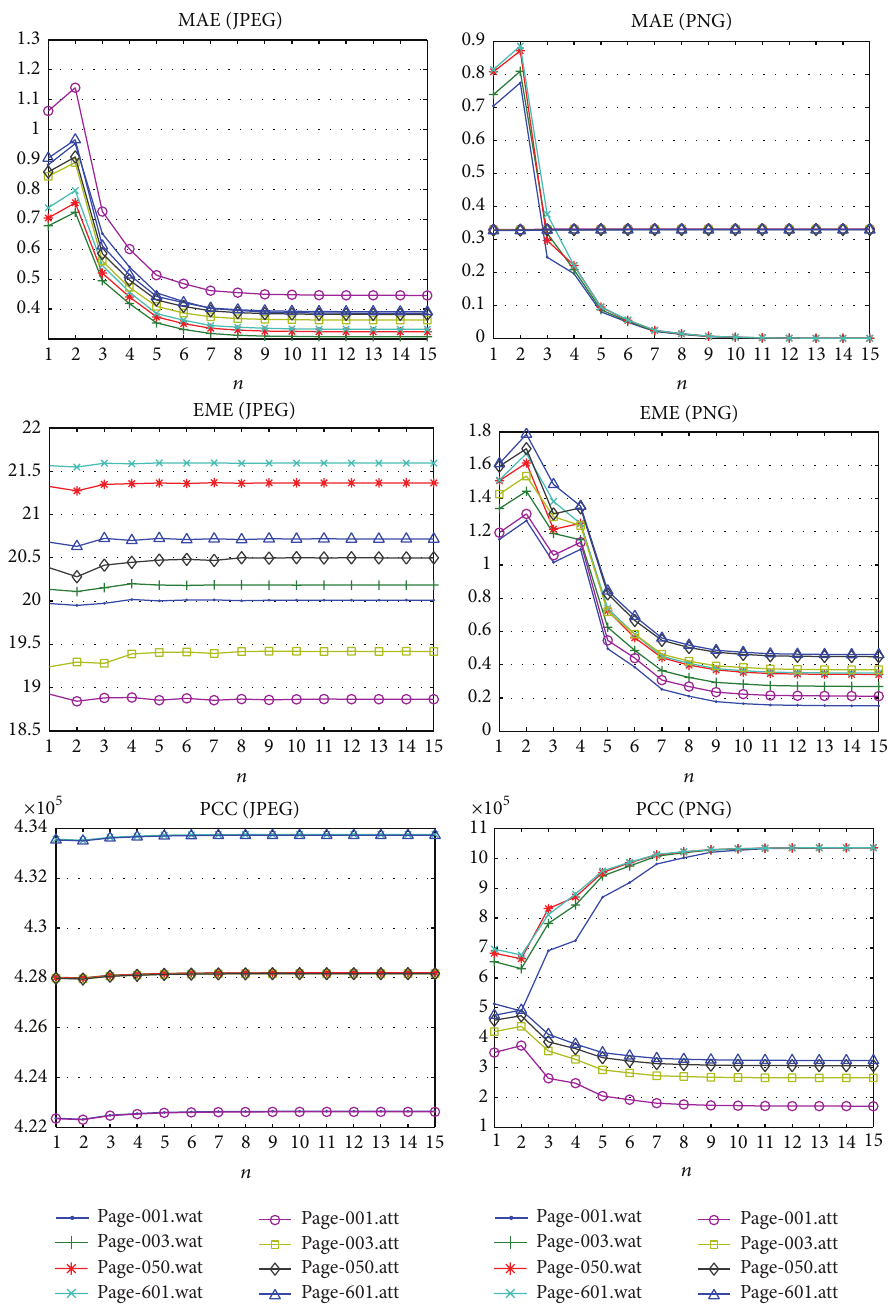
Figure 10: Image quality metrics on Gaussian noise